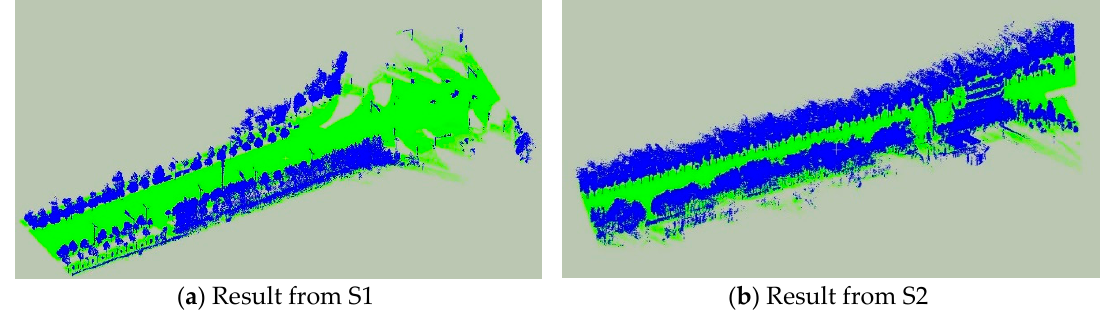
Figure 9. Selected results of ground detection.